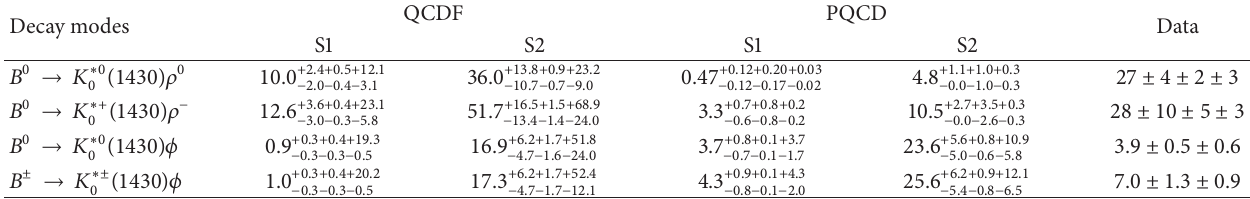
Table 1: Branching ratios (in units of 10 −6 ) of 𝐵 → 𝐾 ∗ 0 (1430)𝜌 and 𝐵 → 𝐾 ∗ 0 (1430)𝜙 in QCDF [15], PQCD [19, 23], and experimental data [26,